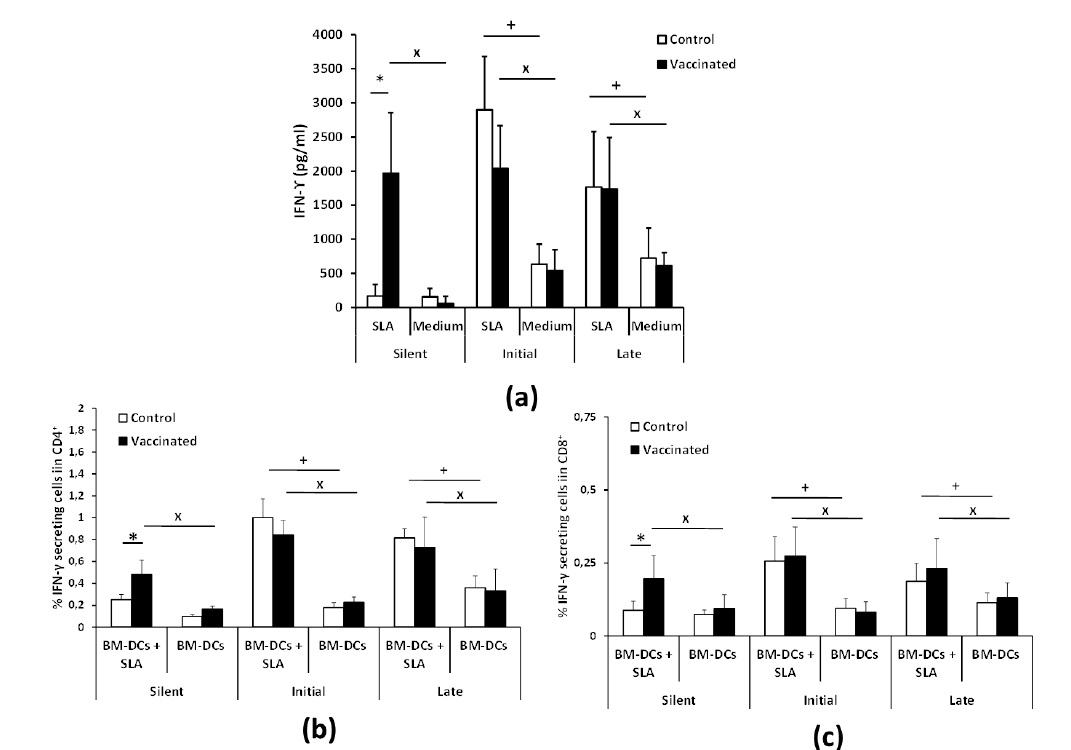
Figure 4. Analyses of parasite-specific IFN- γ production. BALB / c mice (n = 8 per group) were inoculated s.c. in the left footpad with PBS (control group) or vaccinated with 10 7 Li ∆ HSP70-II attenuated parasites prepared in PBS. Twelve weeks after inoculation, animals were challenged i.v. with 10 8 PpyRE9h + L. infantum infective promastigotes. Spleen cell cultures from each mouse were independently established at the silent phase (1 week post-challenge), at the initial phase (5 weeks post-challenge), and at the late phase of infection (11 weeks post-challenge) and stimulated (SLA) or not (medium) with soluble leishmanial antigens for 72 h. IFN- γ levels were measured in culture supernatants by quantitative sandwich ELISA ( a ). Spleen cell cultures established at the indicated phases were independently stimulated for 24 h with BM-DCs pulsed or not with SLA. Afterwards, cells were processed for flow cytometry. The percentages of IFN- γ -secreting cells in CD4 + ( b ) or CD8 + ( c ) gates are shown. All data are represented as the mean ( + SD) and statistics were analyzed by a Student T test. * ( p < 0.05) shows the statistical di ff erences between control and vaccinated mice. + ( p < 0.05) shows the statistical di ff erences between SLA stimulation and non-stimulation in the control group. × ( p < 0.05) shows the statistical di ff erences between SLA stimulation and non-stimulation in the vaccinated group. Results are representative of two independent experiments.